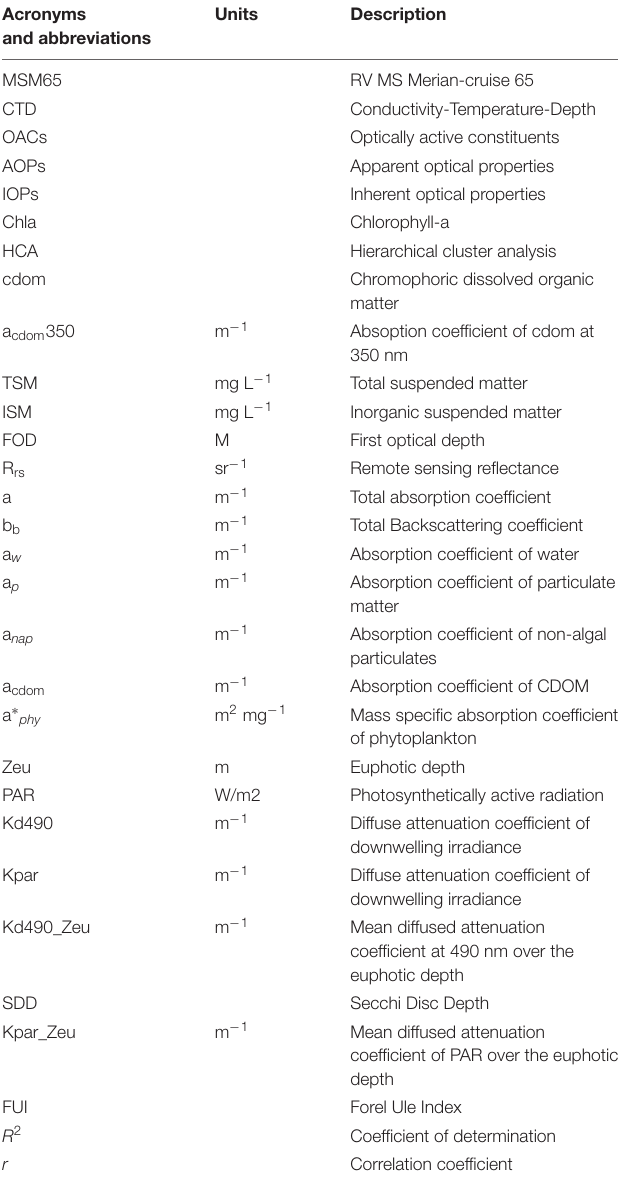
TABLE 1 | List of acronyms and